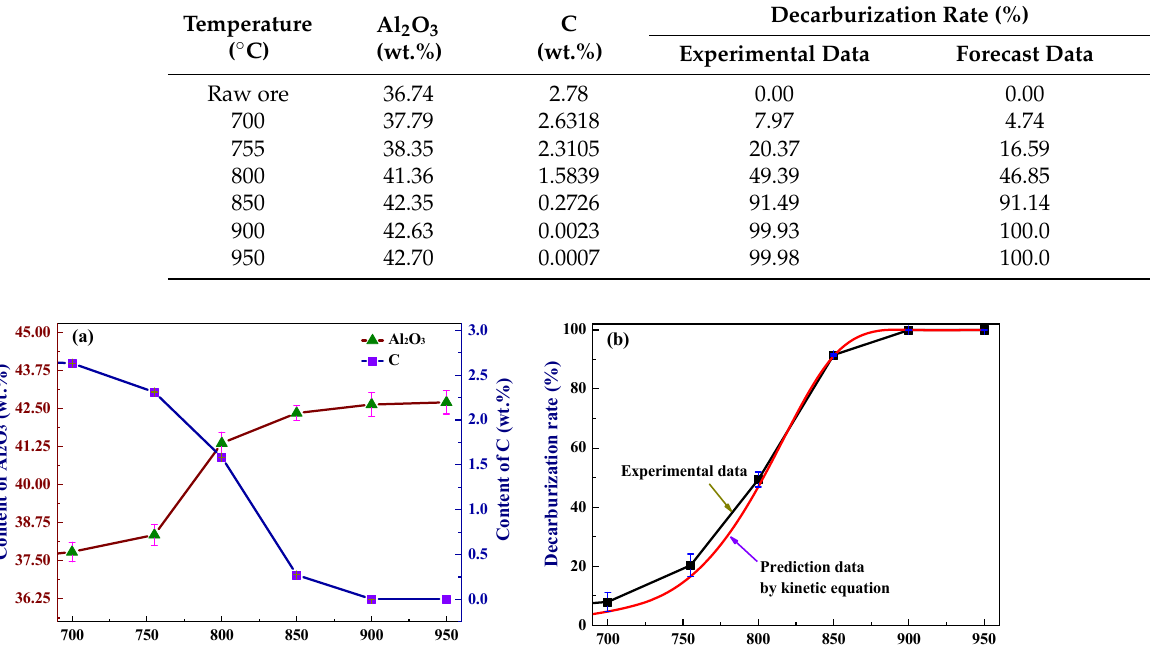
Table 6. Analysis results of decarburization rate of calcined kaolin products.